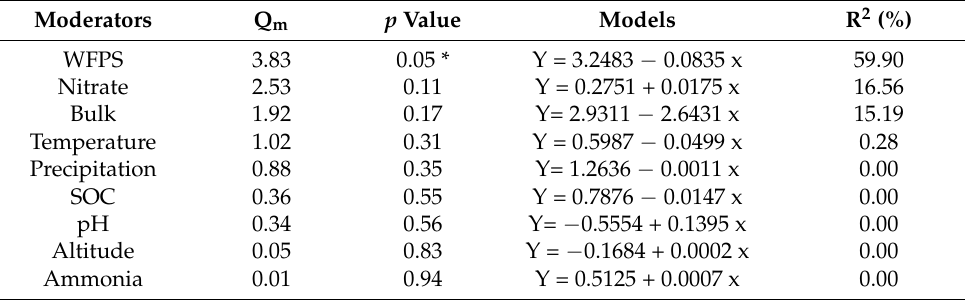
Table 3. Effect of air temperature, altitude, and other factors on effect